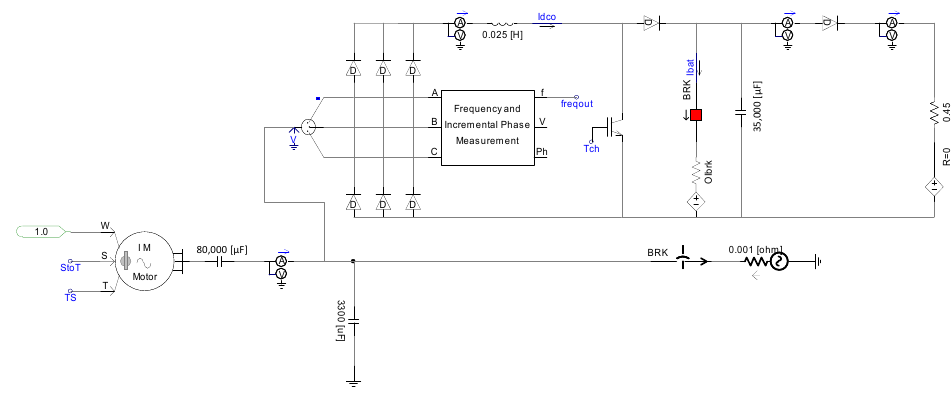
Figure 1. System configuration.